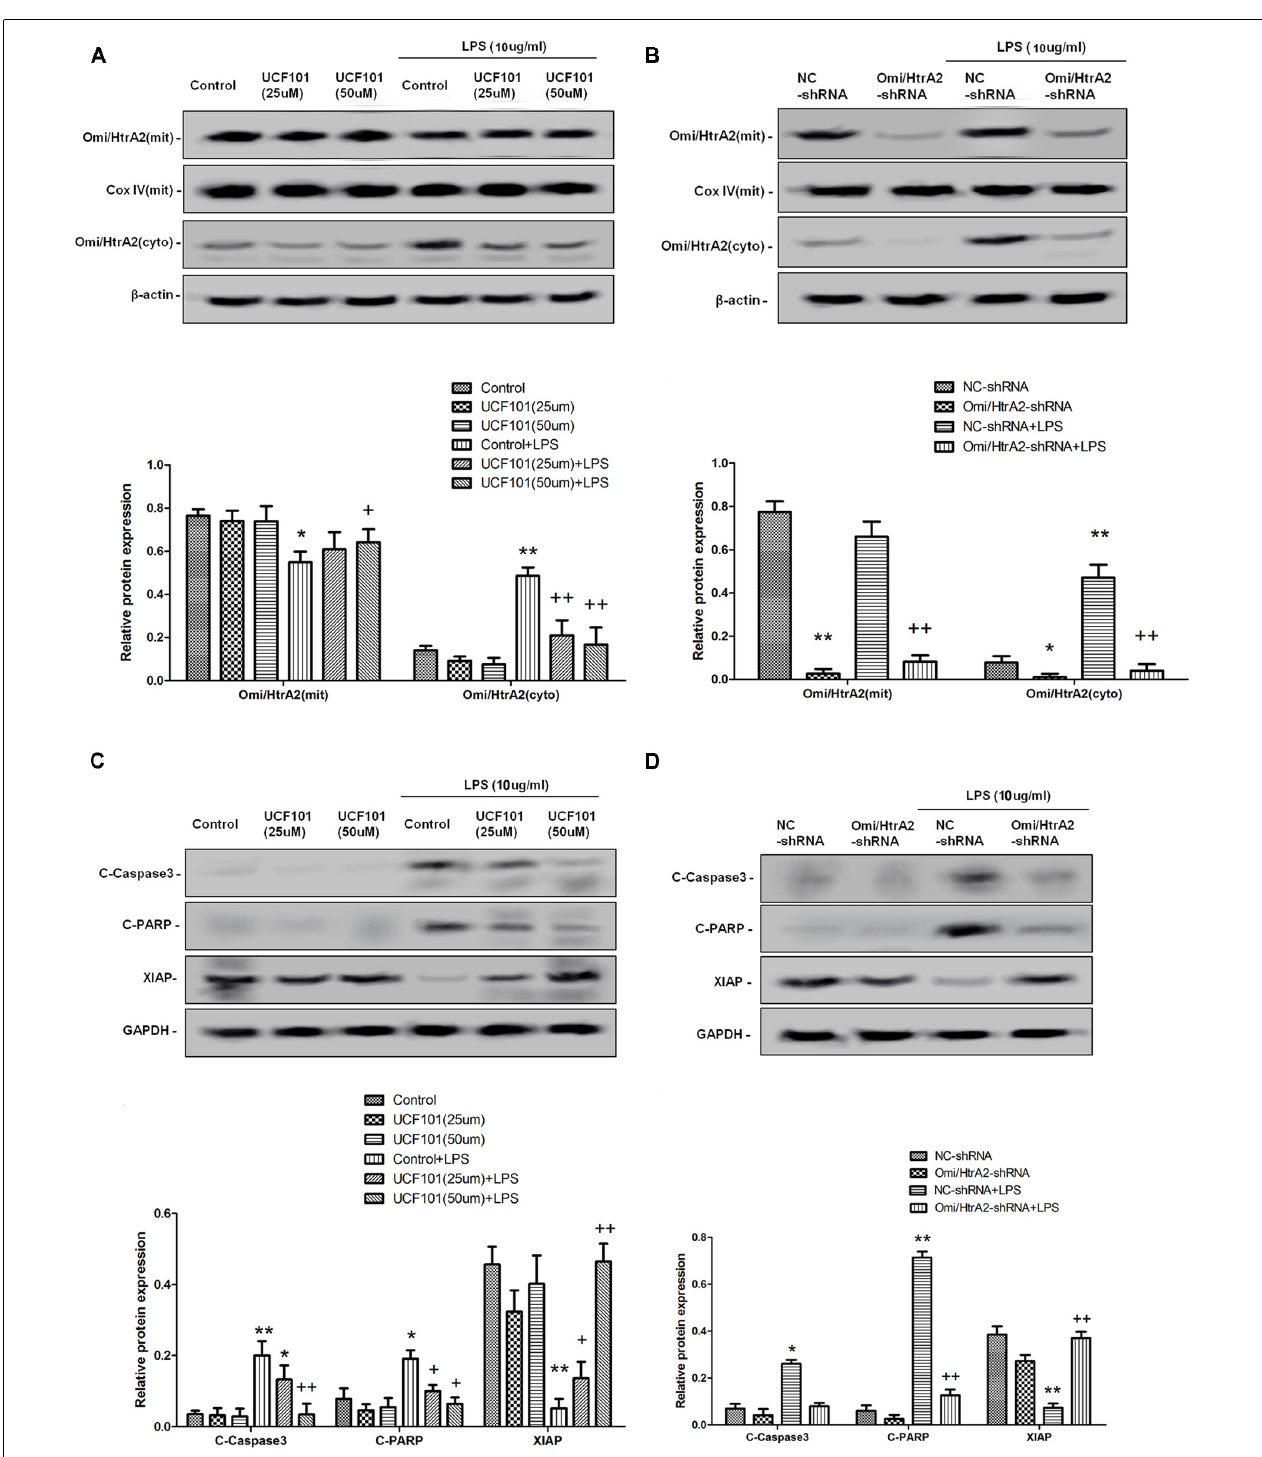
FIGURE 7 | Omi/HtrA2 regulates LPS-induced endothelial cell apoptosis by translocating from mitochondria into cytosol via proteolytic degradation of proteins that can normally inhibit caspase activity. (A) Effects of Omi/HtrA2 protease activity inhibition by UCF-101 or (B) Omi/HtrA2 silencing by Omi/HtrA2 shRNA on Omi release into the cytoplasm in LPS-treated hCMEC/D3 monolayers. Respective bands with β -actin as loading control were shown. (C) Effects of Omi/HtrA2 inhibition by UCF-101 or (D) Omi/HtrA2 silencing by Omi/HtrA2 shRNA on degradation of X-linked inhibitor of apoptosis protein (XIAP), Poly ADP-ribose polymerase (PARP) cleavage, and caspase-3 cleavage in LPS-treated hCMEC/D3 monolayers. Respective bands with GAPDH as loading control were shown. ∗ P < 0.05, vs. control or NC-shRNA, ∗∗ P < 0.01, vs. control or NC-shRNA, + P < 0.05, vs. control + LPS or NC-shRNA + LPS, ++ P < 0.01, vs. control + LPS or NC-shRNA + LPS.